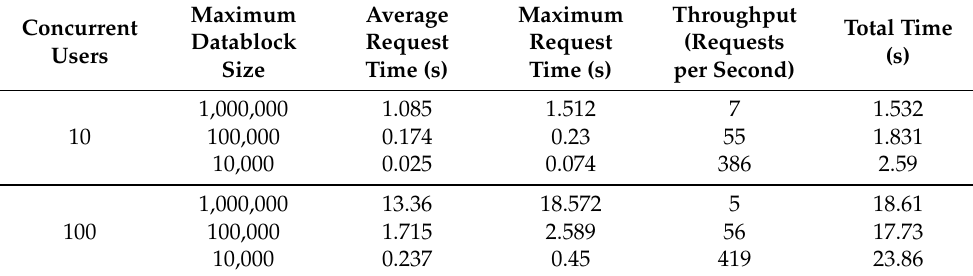
Table 5. Results of the concurrent requests test in Cassandra.